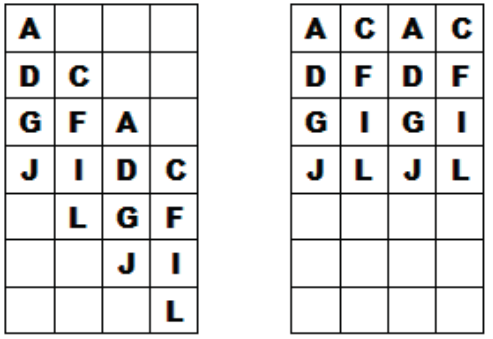
Figure 3. Side-slither collect before and after frame shift correction. Note how even/odd start frames are lined